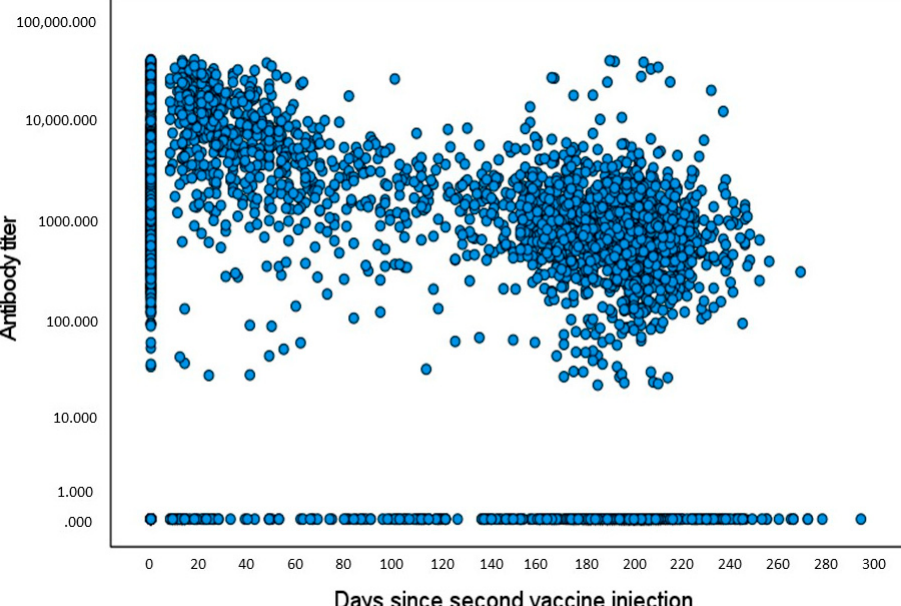
Figure 3. Scatter plot (BIVAR): antibody titers plotted against elapsed time since 2nd vaccination. We used the Pearson correlation with the logarithmic scale to test the relation between antibody titer and days since second vaccine injection.